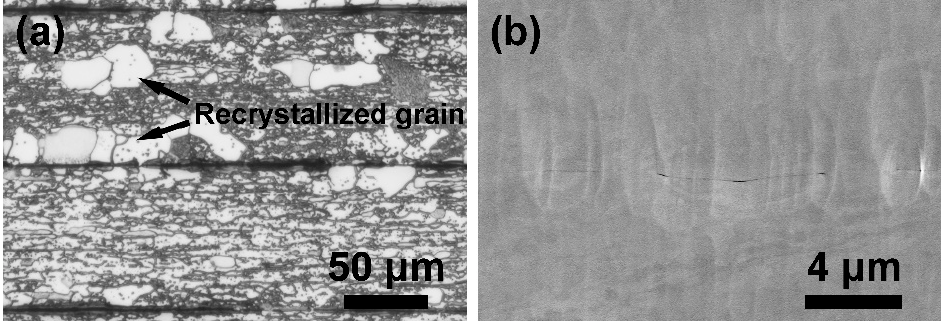
Figure 9. ( a ) The metallographic structure and ( b ) a representative W–W interface of the W foil laminate FAST joined in an artificial operation mode.